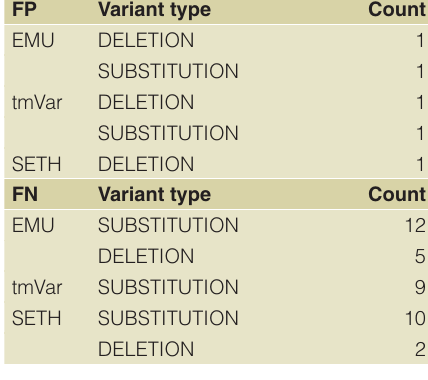
of the other tools is lower. This is explained because there are spe- cific types of DNA variants, e.g. deletions, that are not as well cov- ered by the other tools as by SETH or tmVar. tmVar performance for DNA mutations is higher than any other system when partial matching is used and below SETH when exact matching is consid- ered. As can be seen in Table 5, tmVar has much stronger coverage of protein mutations as compared to DNA mutations. Table 6 and Table 7 contain the frequency of false positives and false negatives made by each tool, grouped by type of genetic variation. Types of genetic variation were manually annotated. There are 8 DNA deletions, 2 DNA insertions/deletions, 42 DNA substitutions and 66 protein substitutions. In addition to a substitution that EMU identified incorrectly, all two other false positives are annotations Table 6. DNA variant extraction error types and their frequency are presented for each system. Only the tools that perform DNA variant extraction are considered. The tools are